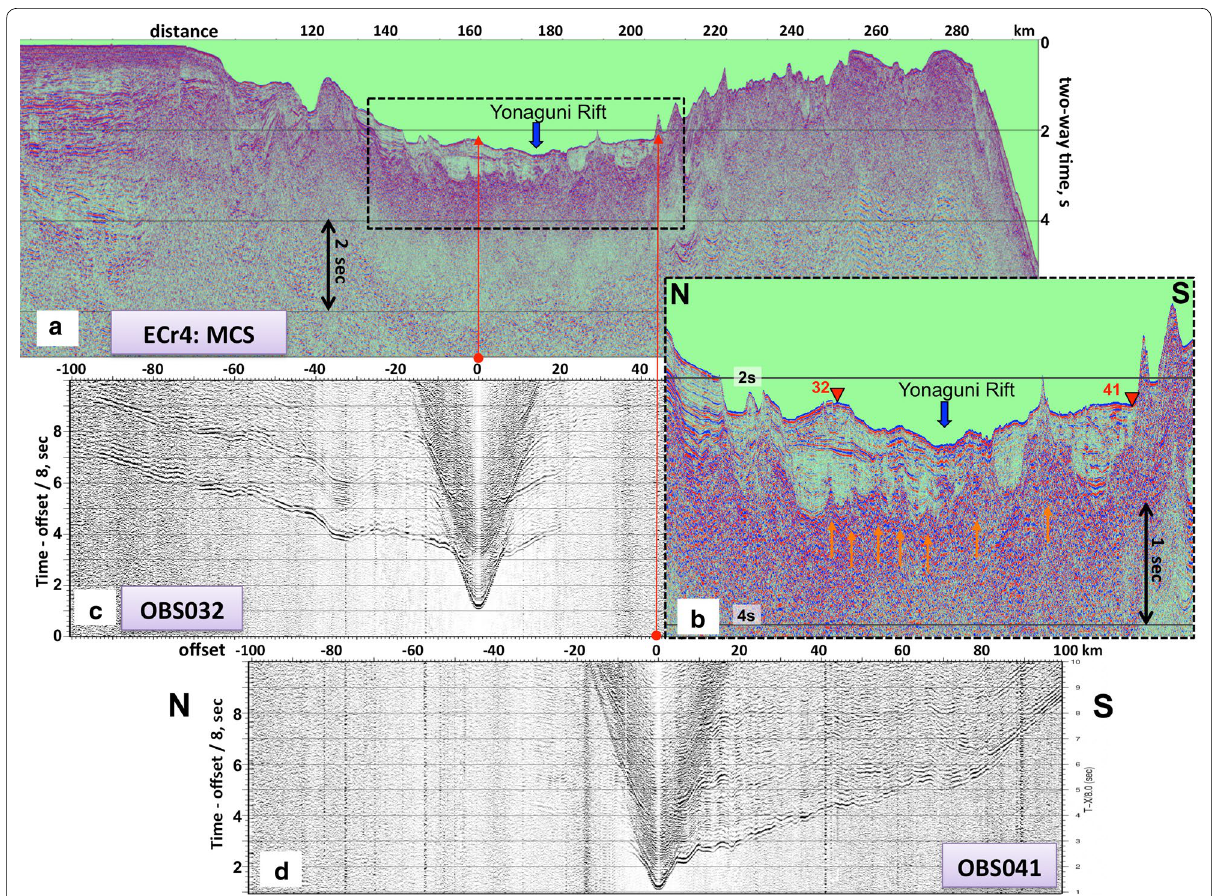
Along‑trough lines ECr21 is a 563-km-long north–south trending line and traverses the northern half of the OT; the line starts from the continental shelf with a water depth of ~ 200 m at the northern end, passes through the Danjo Basin and several topographic highs in the northwestern OT, and intersects the volcanic front at the southern end (Fig. 1). The water depth in the OT varies gradually from 700 m in the north to 1200 m in the south. As the seafloor topography varies substantially along the survey line, the seismic structure shows significantly inhomogeneous features. As shown faults with various scales along the MCS profile.